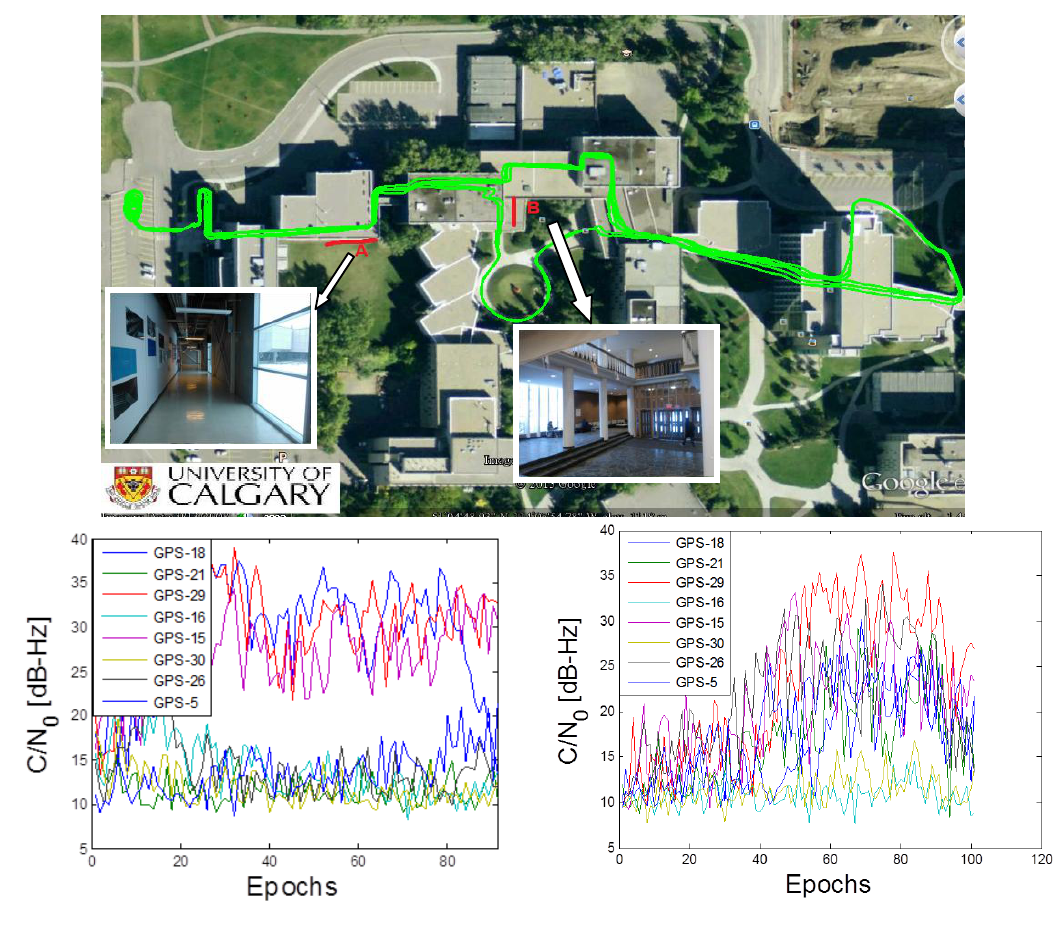
Figure 6. Data collection actual trajectory, indoor scenarios, and corresponding C/N0 plots (one epoch is 0.5 s)—scenario A picture taken facing east, scenario B picture taken facing south.